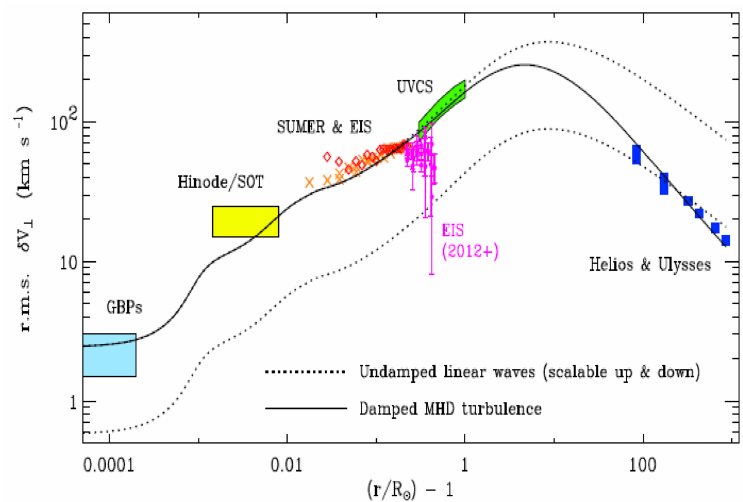
Figure 6. Dependence on radial solar distance of the transverse velocity amplitudes of MHD fluctuations in coronal holes and fast solar wind. The model curves and photospheric G-band bright-point data are taken from Cranmer and van Ballegooijen (2005). Other data are from type II spicule motions observed by Hinode/SOT, nonthermal line broadenings from SOHO, and direct in situ measurement from the Helios and Ulysses missions and composed by Cranmer et al. (2017). A note of caution is appropriate for this integrated overview plot. The shown velocity fluctuations have been inferred from very different empirical data sets and relate to completely different frequency regimes of measurements made at various radial distances from the